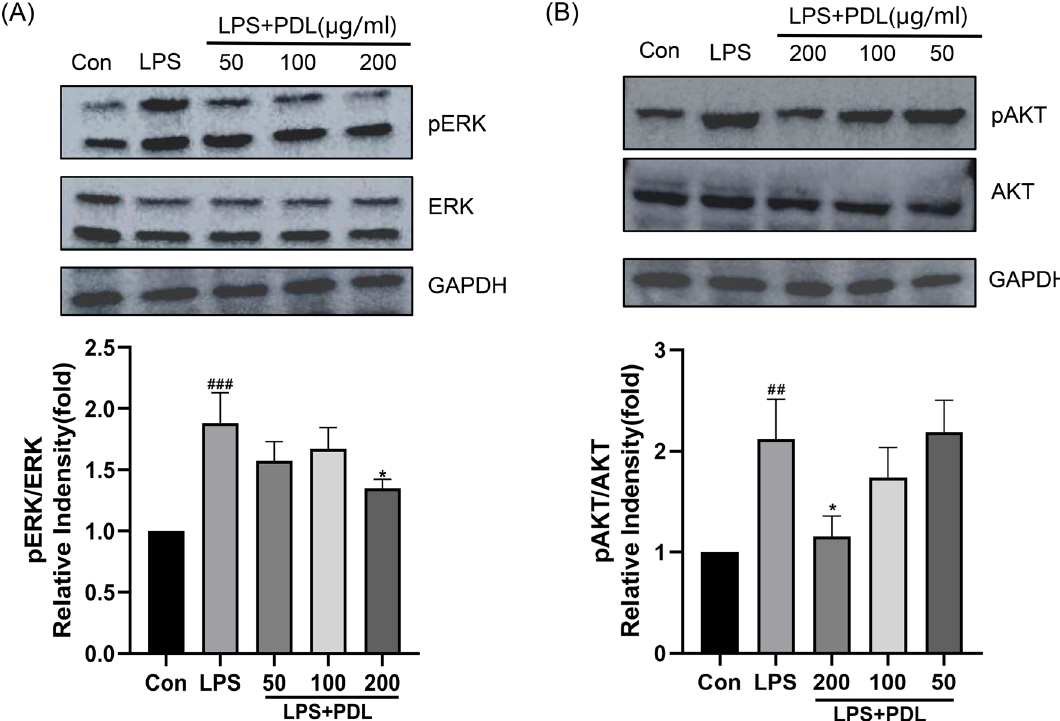
Figure 8. Effect of PDL on ERK/Akt phosphorylation in LPS-induced RAW 264.7 cells. The protein expressions of ( A ) ERK and ( B ) Akt proteins were visualized by Western blotting analysis. Quantitative analysis of each protein by image J. The values of each control were used to estimate the levels of ERK and Akt. The values are shown as the mean ± SD (n = 3). ## p < 0.01, ### p < 0.005 vs vehicle control cells. *p < 0.05 vs LPS-treated